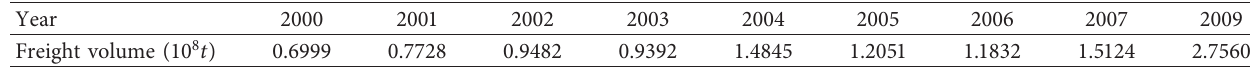
Table 1: Xi’an’s freight volume from 2000 to 2008.